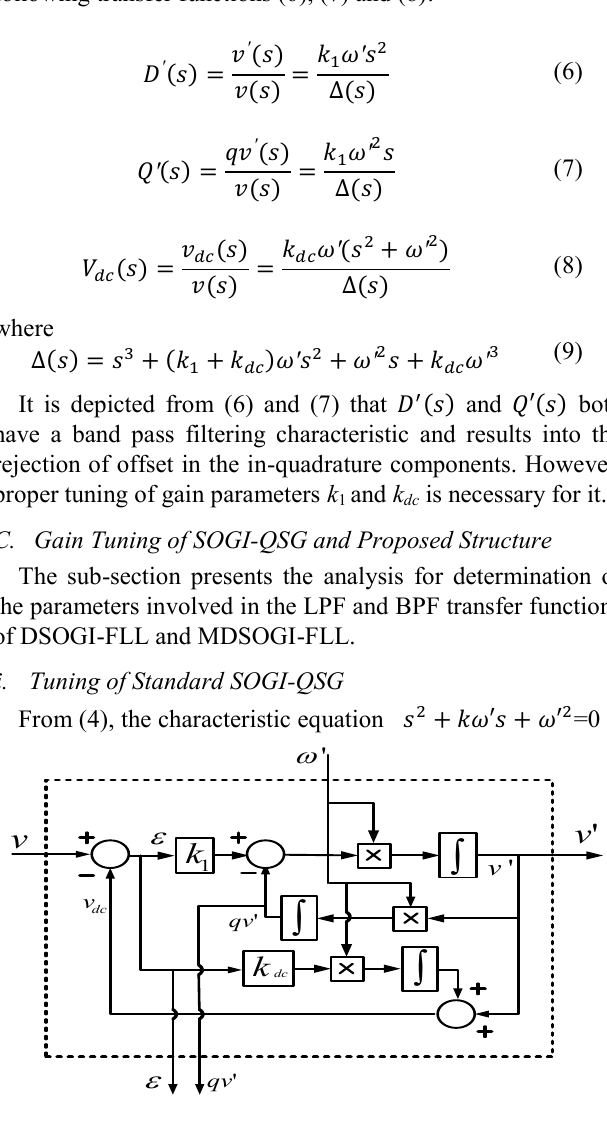
Fig. 3 Block diagram of Modified SOGI-QSG